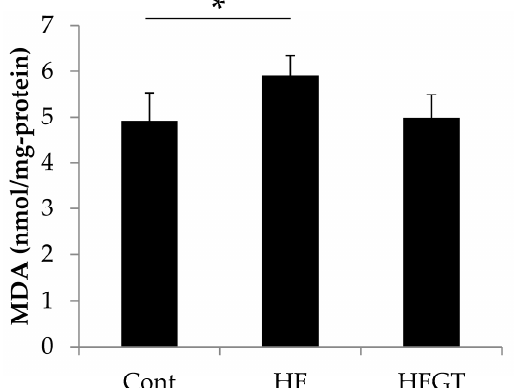
Figure 3. Effects of GTEs intake on HF diet-induced oxidative stress in SAMP8 mice. The levels of malondialdehyde (MDA), a lipid peroxide degradation product, in the cerebral cortex were measured by thiobarbituric acid reactive species (TBARS) assay. Data are means ± S.D. One-way ANOVA followed by Dunnett’s test was used for comparison among groups (Number of samples, N = 4). * p < 0.05.